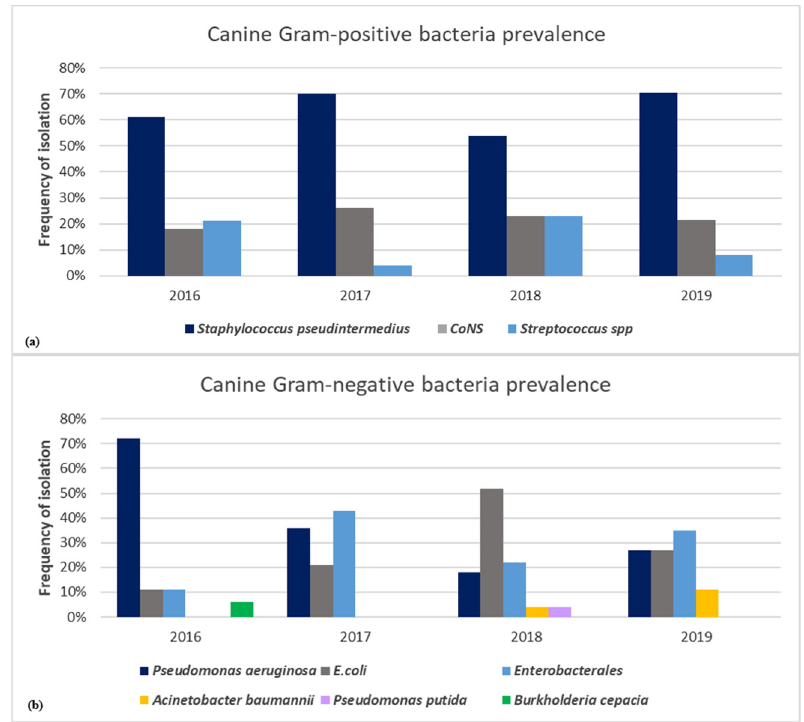
Figure 4. Frequency of isolation by year of Gram-positive ( a ) and Gram-negative ( b ) bacteria associated with canine skin infections .